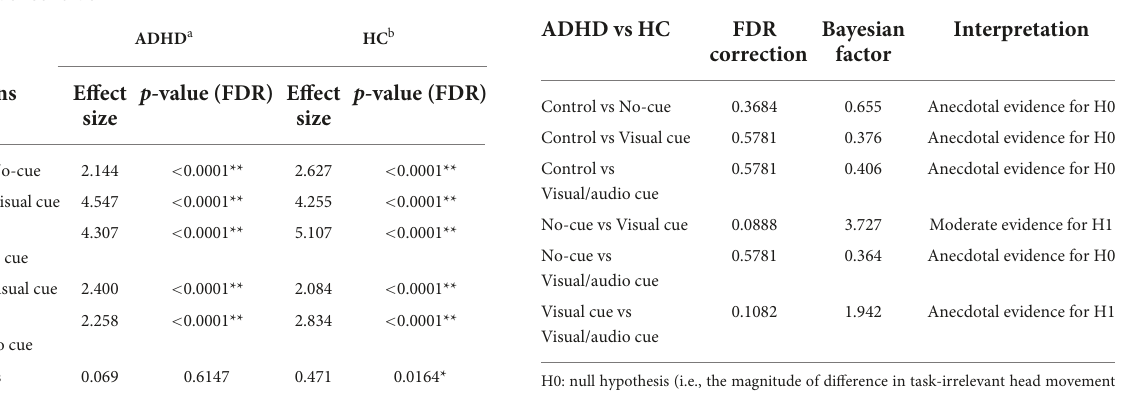
from showing no significant difference between the visual and visual/audio cue conditions in the ADHD group ( p = 0.615).